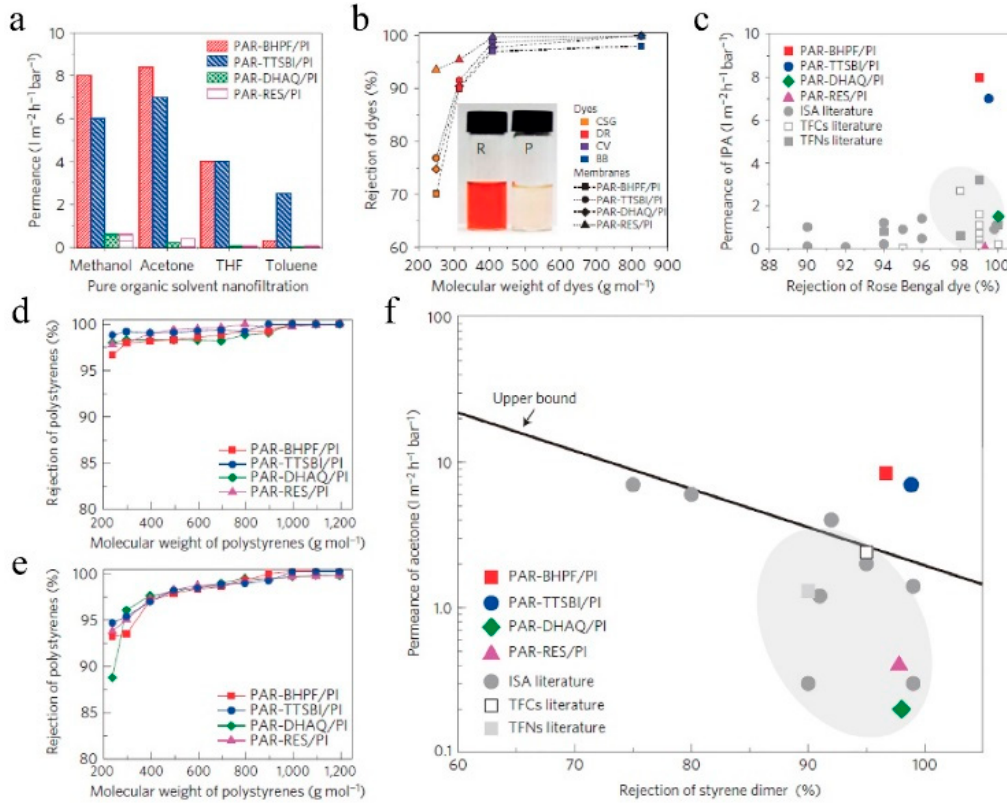
Figure 17. Organic solvent nanofiltration. ( a ) Pure solvent permeances for methanol, acetone, tetrahydrofuran (THF), and toluene through polyarylate (PAR) nanofilm composite membranes prepared on crosslinked polyimide (PI) supports. Nanofiltration was conducted in a crossflow filtration system at 30 ◦ C under 30 bar. ( b ) Rejection versus molecular weight of dyes: brilliant blue (BB, 826 g/mol), crystal violet (CV, 408 g/mol), disperse red (DR, 314 g/mol), and chrysoidine G (CSG, 249 g/mol) in methanol. Inset photo shows the retentate (R, left) and permeate (P, right) samples for PAR-RES/PI. Nanofiltration was conducted separately for each dye in a crossflow filtration system at 30 ◦ C under 30 bar. ( c ) Isopropanol (IPA) permeance versus the rejection of Rose Bengal (1017 g/mol) for polyarylate/PI nanofilm composite membranes versus typical, integrally skinned asymmetric (ISA), thin-film composite (TFC), and thin-film nanocomposite (TFN) membranes reported in the literature. Nanofiltration was conducted in a dead-end stirred cell (500 r.p.m.) at 30 ◦ C under 30 bar. d and e) Rejection versus the molecular weight of polystyrene oligomers for polyarylate/PI nano-film composite membranes. Nanofiltration of a feed solution comprising polystyrene oligomers dissolved in acetone ( d ) or THF ( e ), respectively, which was conducted in a crossflow filtration system under 30 bar at 30 ◦ C. ( f ) The permeance of acetone versus the rejection of α -methyl styrene dimer (236 g/mol) for polyarylate/PI nanofilm composite membranes. Typical nanofiltration data of ISA membranes, TFC membranes, and TFN membranes reported in the literature are included. Based on the reported literature value, the upper-bound line is manually added to show a trade-off between permeance of solvent and rejection of solute molecules. Reproduced from Reference [39].